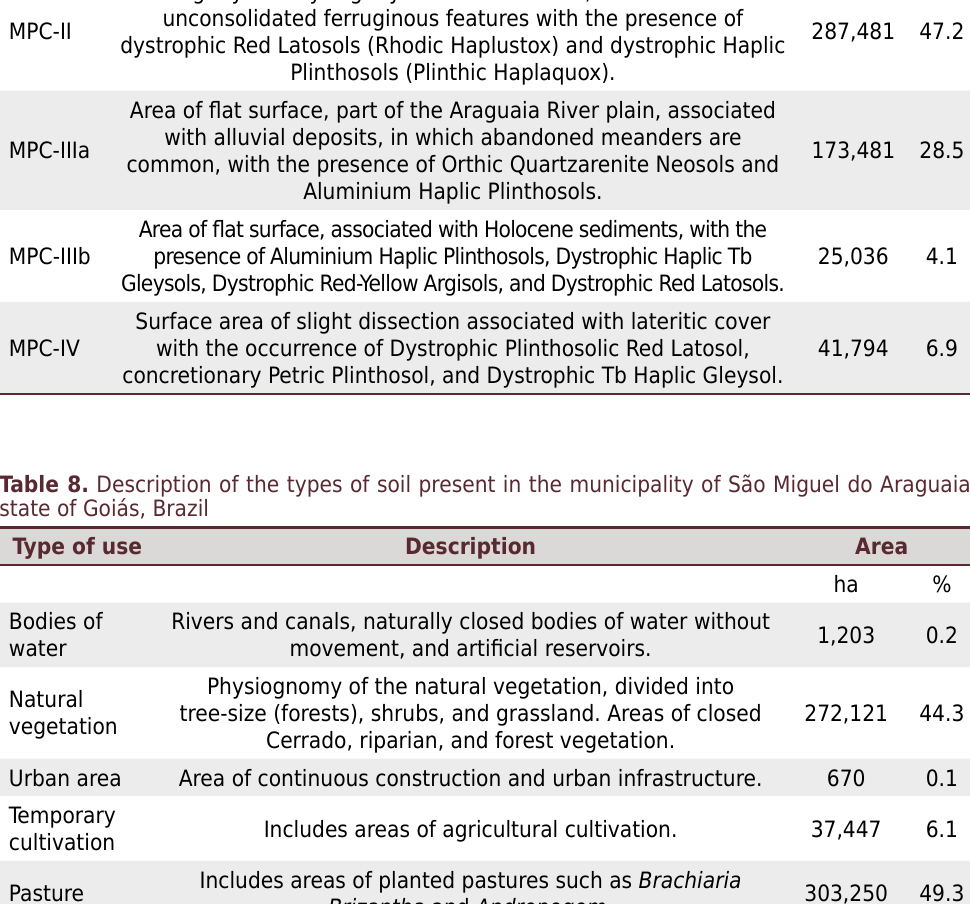
Table 7. Criteria for defining the morphopedological compartments (MPC) Criteria for definition